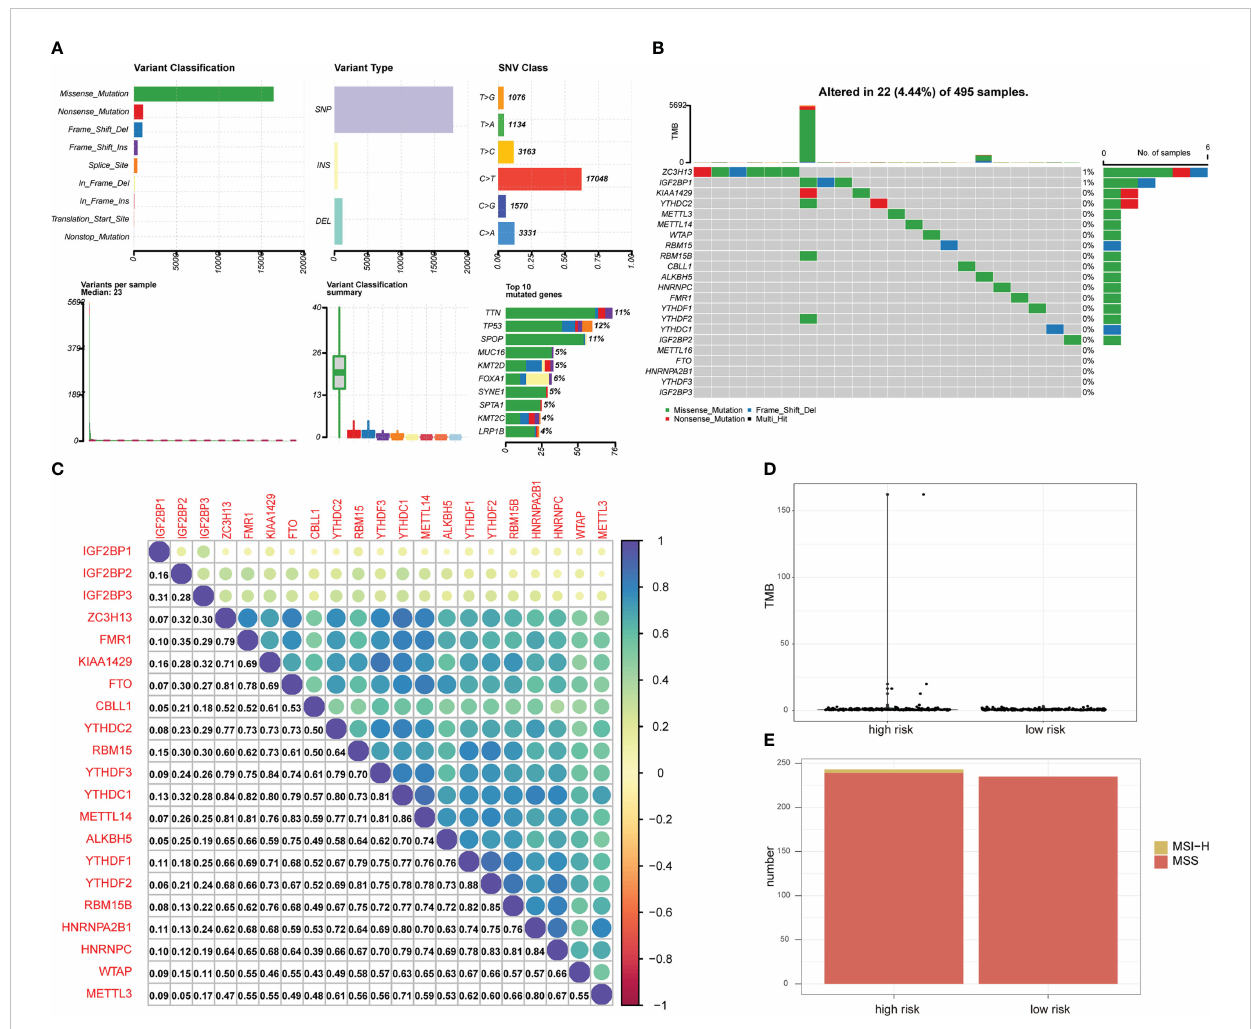
FIGURE 3 Mutation status of m 6 A-related genes in PRAD patients. (A) Summary of PRAD patients mutation data from TCGA. (B) Mutation map of m 6 A-related genes in PRAD patients from TCGA. Samples are ordered according to somatic nonsynonymous mutational burden and genes are ordered by mutation frequency, with various colors indicating different mutation types. Subsection above legend shows mutational burden. (C) The expression level correlation of m 6 A-related genes in the gene expression pro fi le of PRAD patients from TCGA. The numbers in the fi gure and the annotation bar on the right indicate the magnitude of the correlation. (D) Differences in TMB between PRAD patients in high-risk group and low-risk group. (E) Differences in MSI status between PRAD patients in high-risk group and low-risk